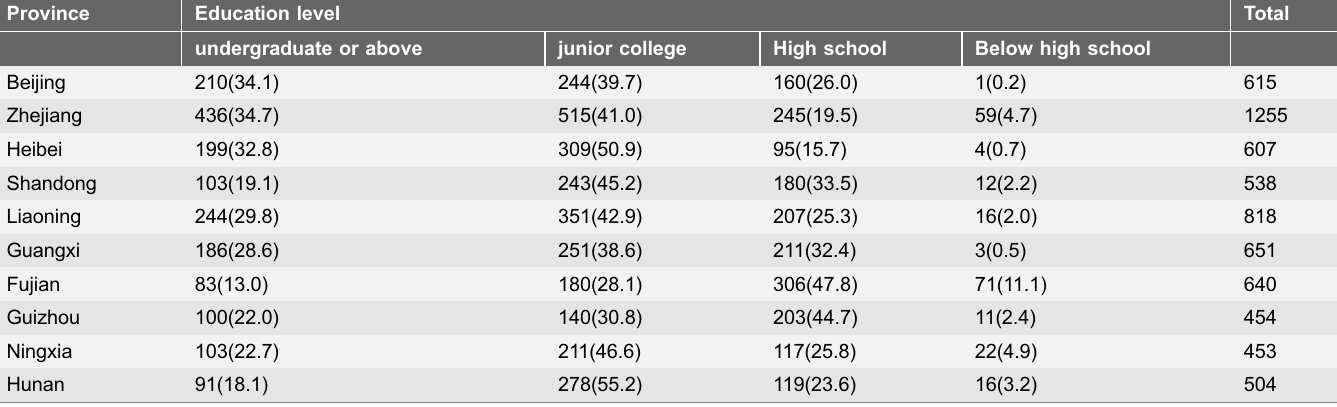
Table 2. Distribution of total health workers by education level in each province (n 5 10).